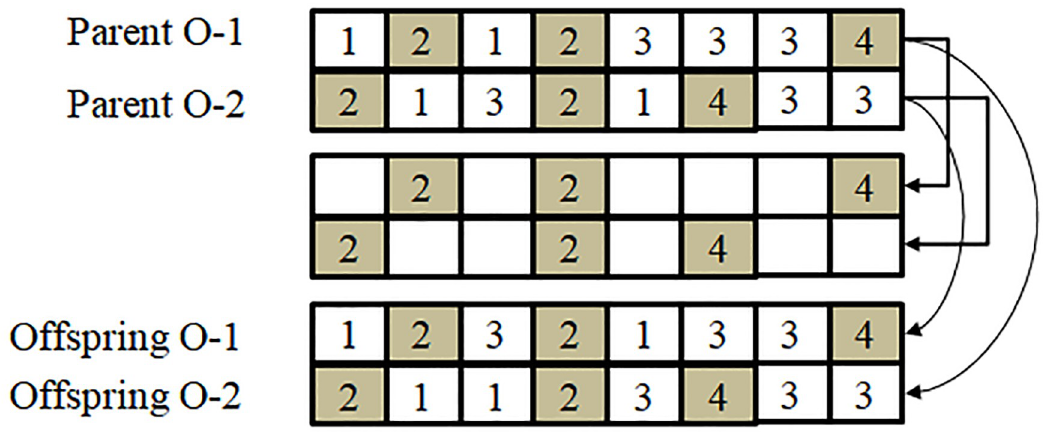
Fig 4. Schematic diagram of operation